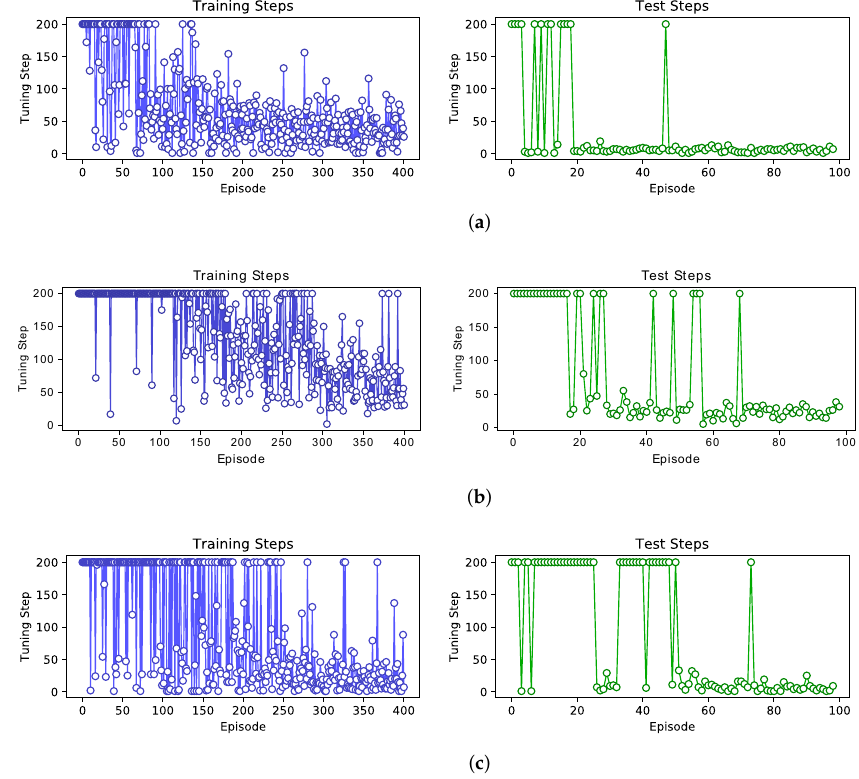
Figure 8. Tuning steps of the training and test episodes in three different reward settings: ( a ) The knowledge-inspired reward. ( b ) The Euclidean distance reward. ( c ) Without any shaping reward. We conduct a test episode after every four training episodes. The maximum tuning step is set to 200 for both training and test